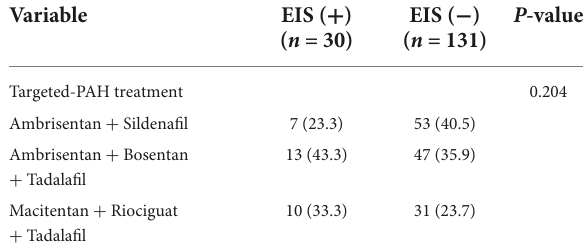
TABLE 1 Demographic, hemodynamic, cardiopulmonary exercise testing, and echocardiographic data in patients with or without